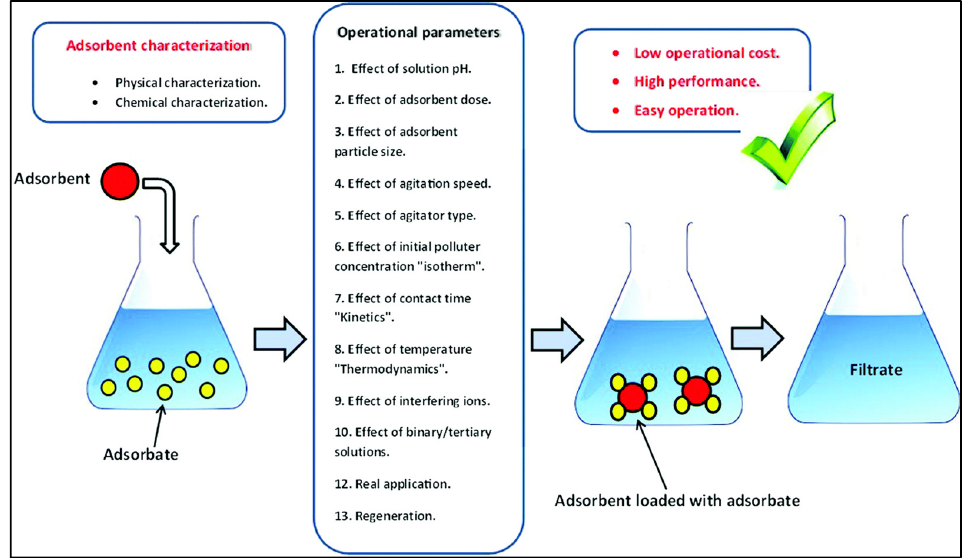
Figure 8. Schematic diagram of batch adsorption [174].